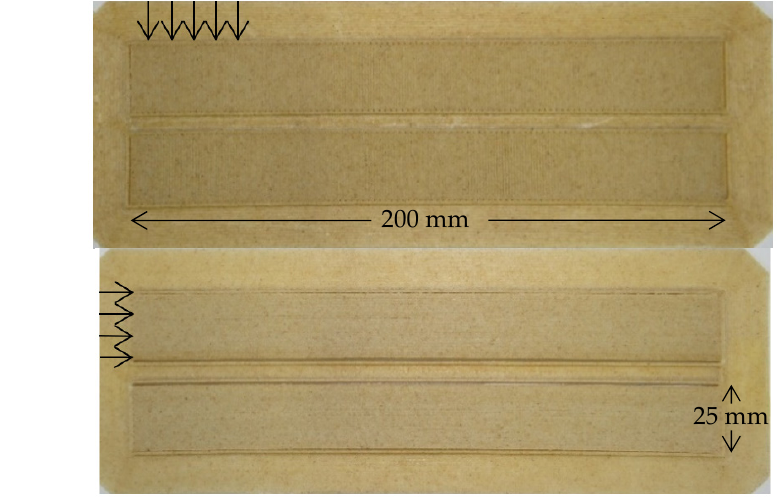
Figure 2. 3D printing tensile specimens at ( a ) 90° and ( b ) 0° with brim platform.